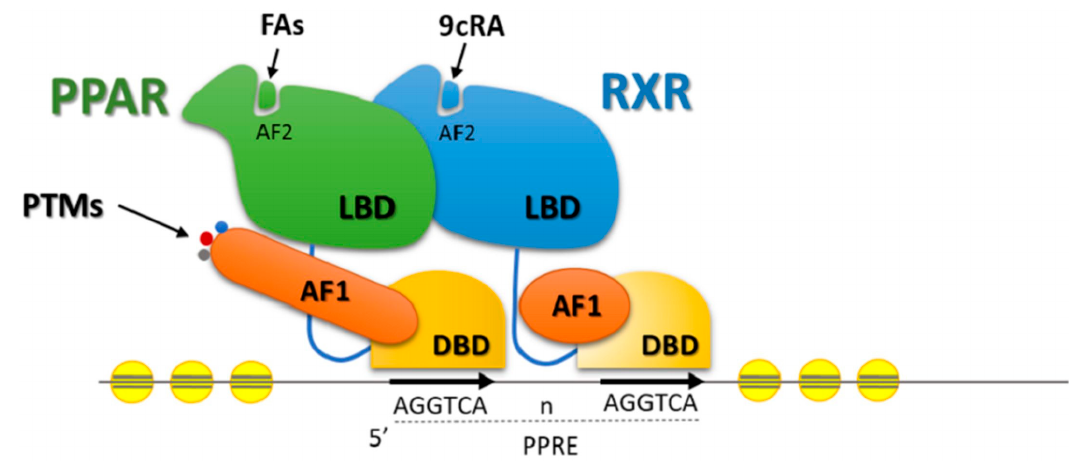
Figure 3. Diagram representing the binding of a nuclear receptor to the DNA. PPAR: peroxisome proliferator-activated receptor, RXR: retinoid X receptor, LBD: ligand-binding domain, PTMs: post-translational modifications, 9cRA: 9-cis retinoic acid, FAs: fatty acids, AF: activation function, DBD: DNA-binding domain, PPRE: peroxisome proliferator response elements.